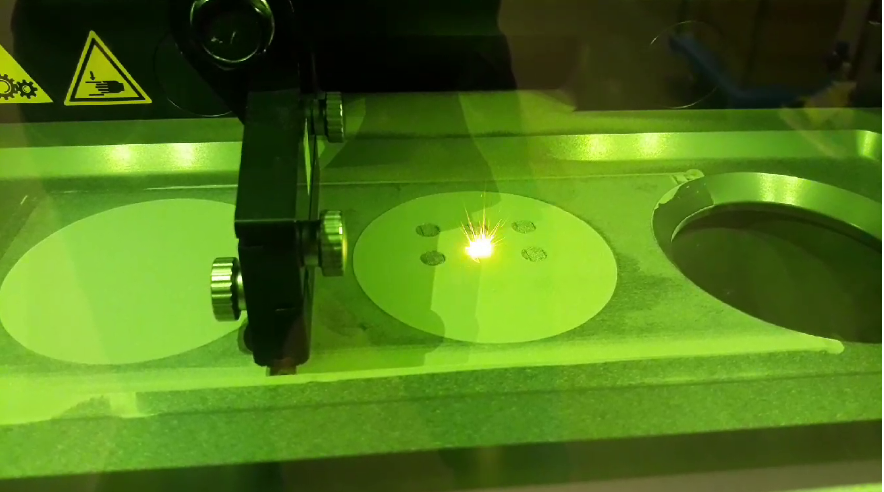
Figure 1. 3D printing of steel using laser-based powder bed fusion (Trumpf TruPrint